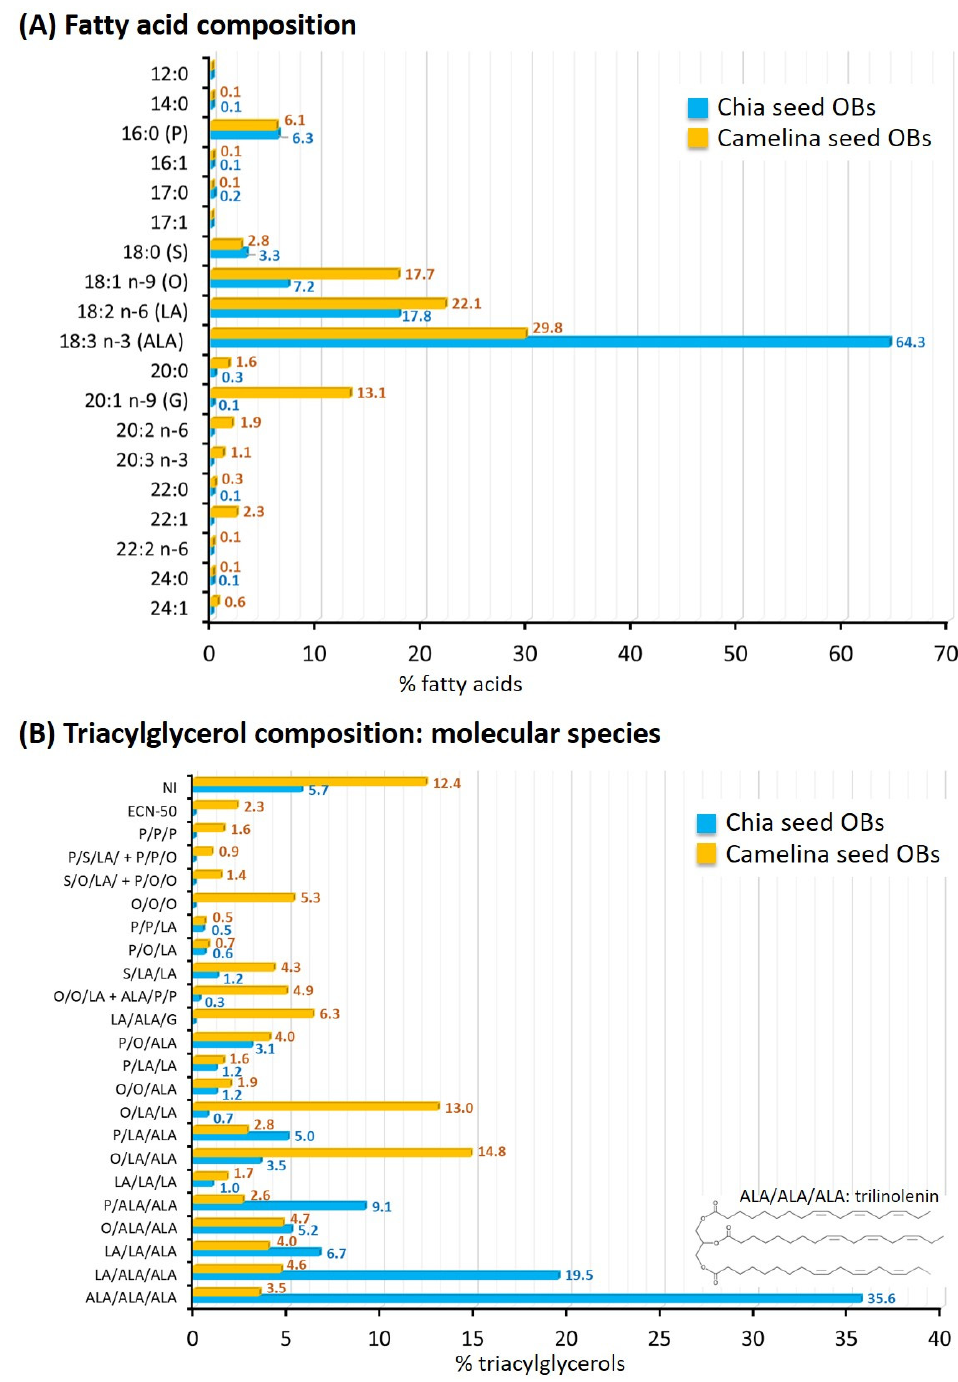
Figure 5. Lipid composition of chia and camelina seed oil bodies (OBs). (A) Fatty acid composition (g/100 g total fatty acids), ( B ) composition of triacylglycerol (TAG) molecular species (g/100 g total TAG). Abbreviations: ALA = α -linolenic acid, LA = linoleic acid, O = oleic acid, P = palmitic acid, S = stearic acid and G = gondoic acid; symbols O/LA/ALA, LA/ALA/ALA and others indicate the three fatty acids present in TAG but do not represent their regiospecific sn -position. Values are reported as means ± SD of three independent extractions and 3 analyses per extraction (n = 9). The total PUFA accounted for 82.1 ± 0.2% in chia seed OBs and 55.0 ± 0.1% in camelina seed OBs. The monounsaturated fatty acids represented 7.5 ± 0.1% and 33.9 ± 0.1% in chia and camelina seed OBs, respectively. The saturated fatty acids represented 10.4 ± 0.1%